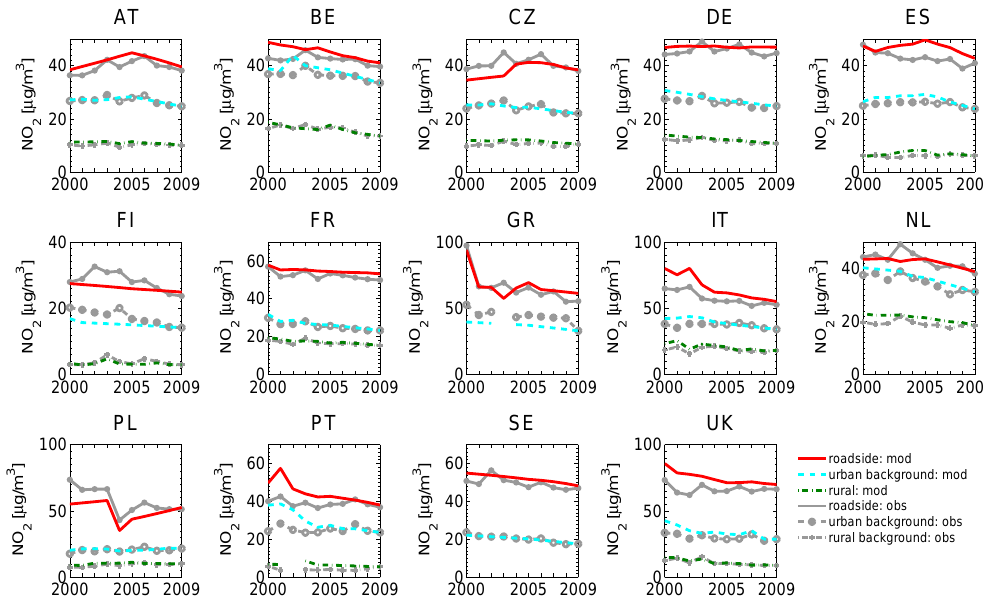
Fig. 9. Annual mean country average NO 2 concentrations modelled at different categories of AirBase monitoring stations in 14 EU Member States (coloured lines), compared to the observed values (grey